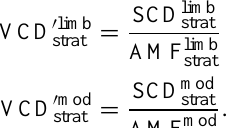
from the offset-corrected SCD limb SCD limb strat = VCD 0 limb strat